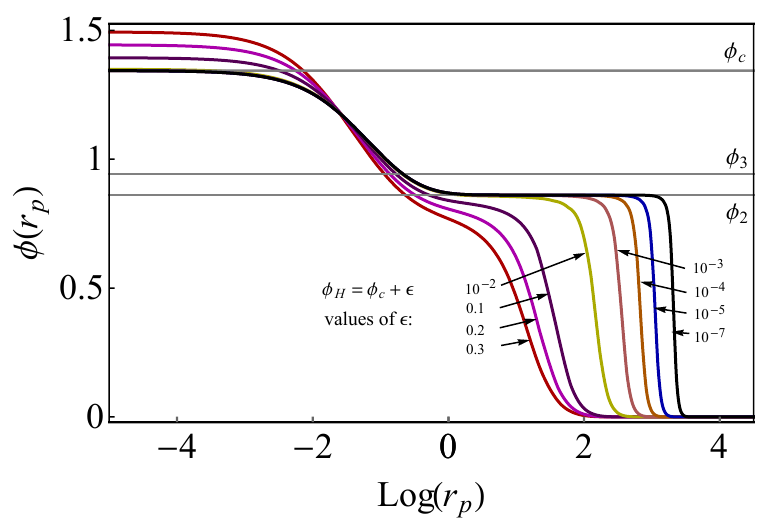
Figure 7 . Scalar (cid:12)eld as a function of the proper distance r p along the holographic direction, measured from the horizon, for di(cid:11)erent solutions with (cid:30) H approaching (cid:30) c from the